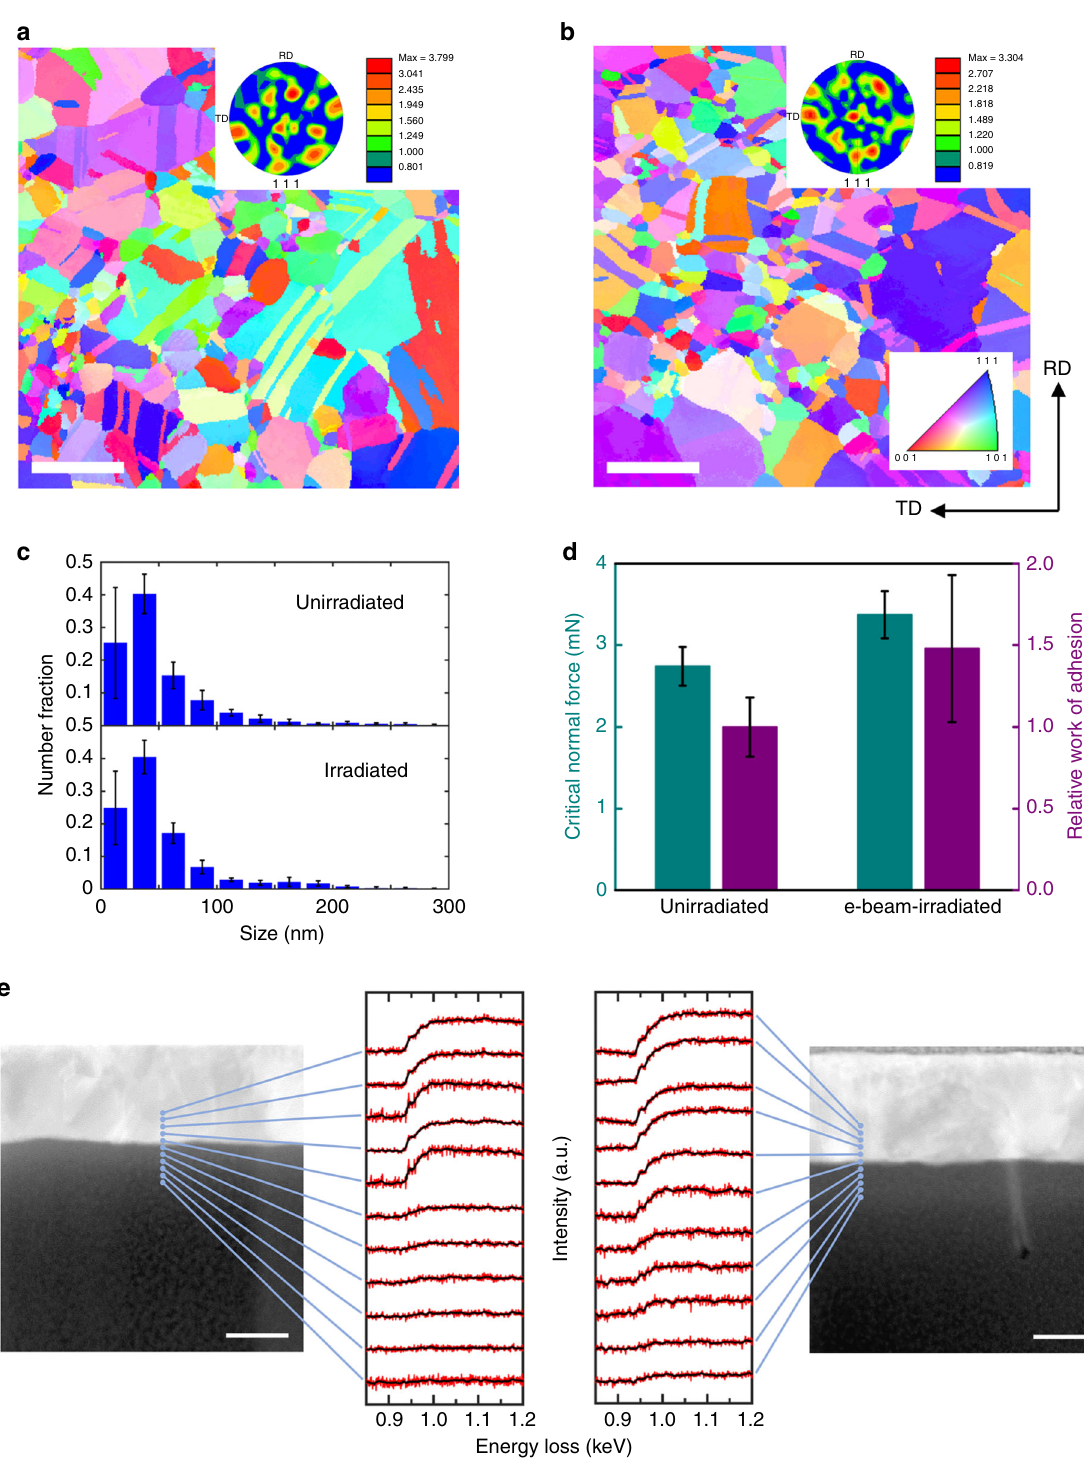
Fig. 2 Investigation of e-beam induced changes in the Cu fi lm – PI system. Inverse pole fi gure maps and the inset of (111) pole fi gures of ( a ) unirradiated and ( b ) e-beam-irradiated Cu thin fi lms obtained from ASTAR TM analysis and ( c ) the grain-size distribution in each case. d The critical normal force ( L cr ) extracted from a nanoscratch test measuring the normal force at the Cu – PI interface at the onset of delamination. The relative value of work of adhesion ( W ) between irradiated and unirradiated samples was then calculated, showing better adhesion for the irradiated sample. e The electron energy loss spectroscopy data collected from different positions at 5 nm intervals across the Cu – PI interface for the unirradiated (left) and irradiated (right) samples. Red lines are the raw data, and black lines are their averages over 20 neighboring points. The probe positions are denoted on the high-angle annular dark fi eld scanning transmission electron microscopy images. Error bars represent the standard deviation ( c , d ). Scale bars, 200 nm ( a , b ); 50 nm ( e